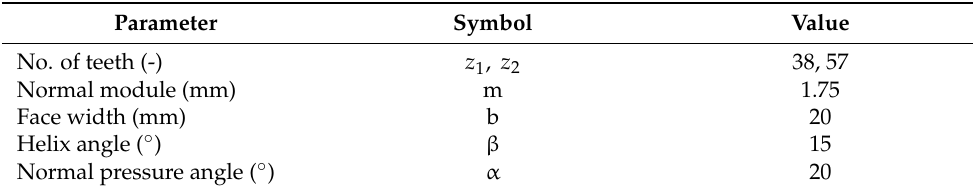
Table 1. Gear pair